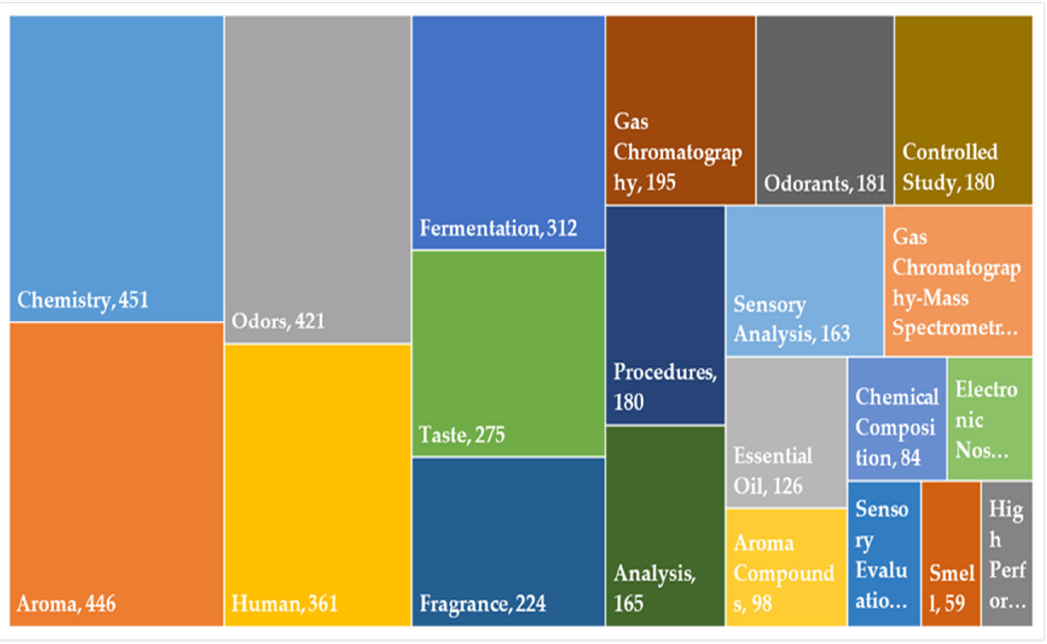
Figure 6. The number of related words.